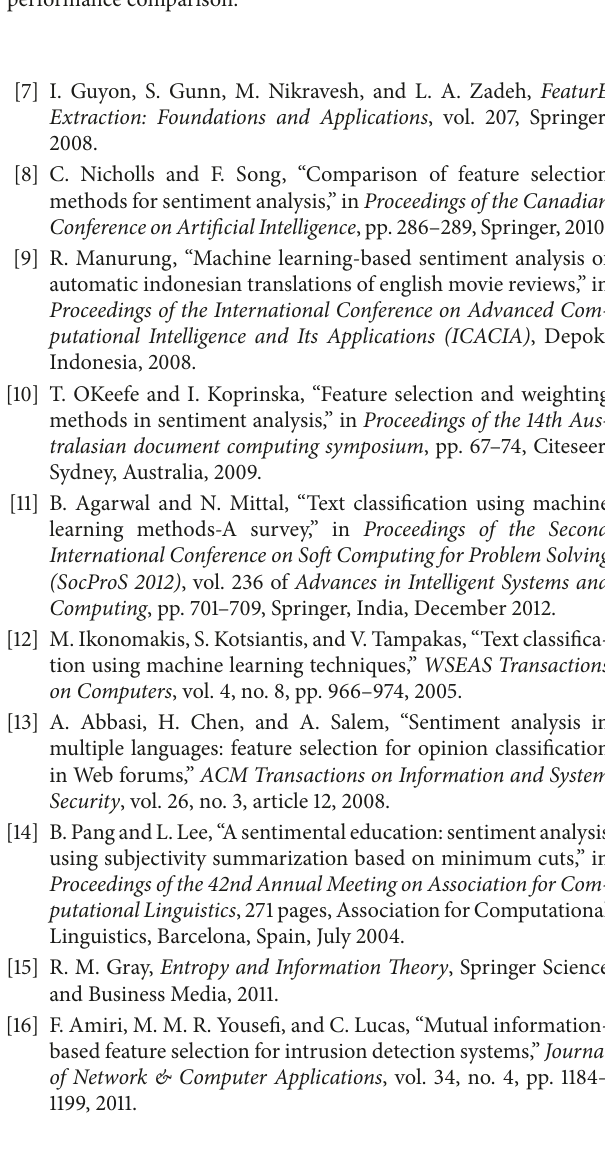
Figure 3: Sentiment classifier performance